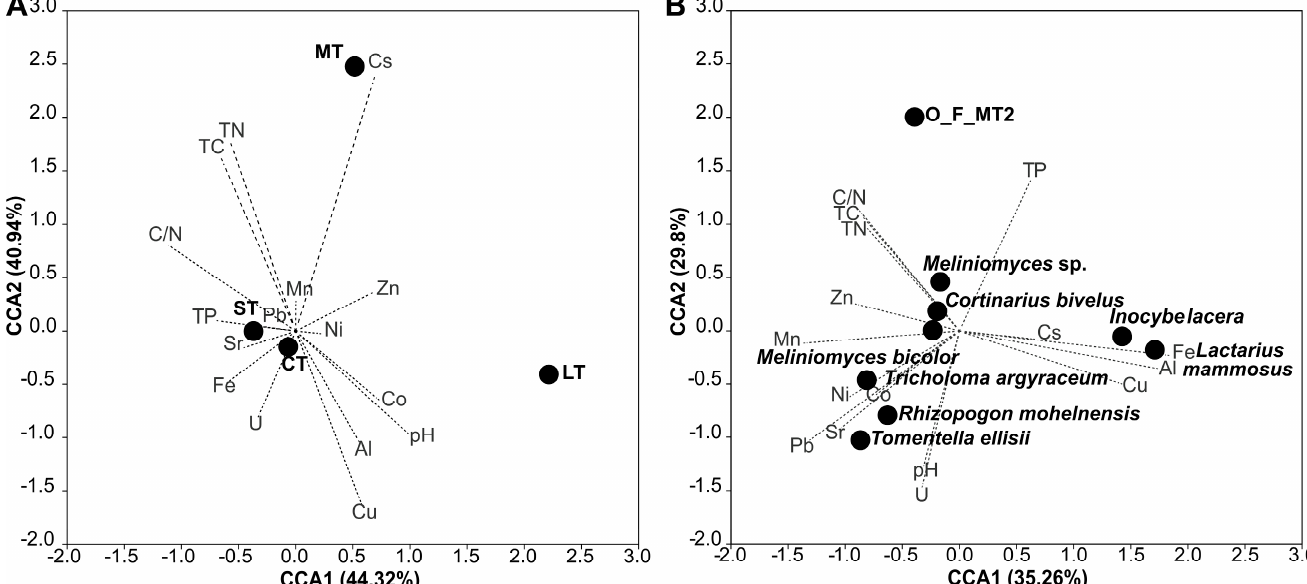
Figure 5. Canonical correspondence analysis biplot representing the correlation ( A ) between soil parameters and exploration types of mycorrhizae and ( B ) between soil parameters and mycorrhizal taxa described for field plants. CT—contact exploration type, ST—short-distance exploration type, MT—medium-distance exploration type, LT—long-distance exploration type.